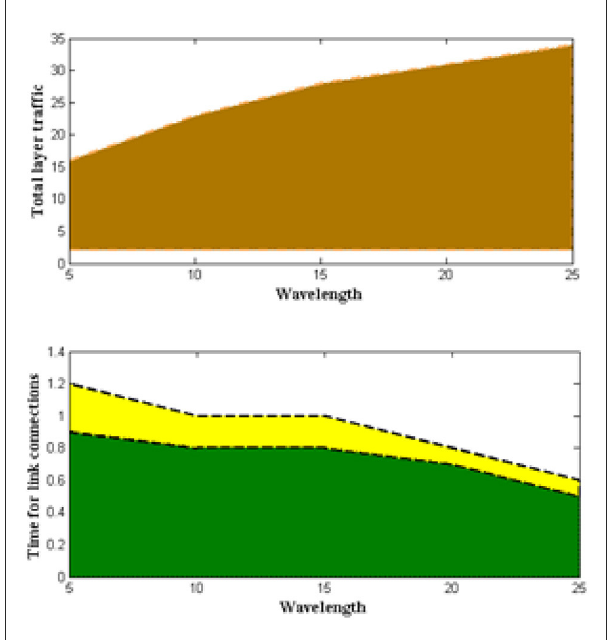
FIGURE4 Reflection index with primary and secondary focus.